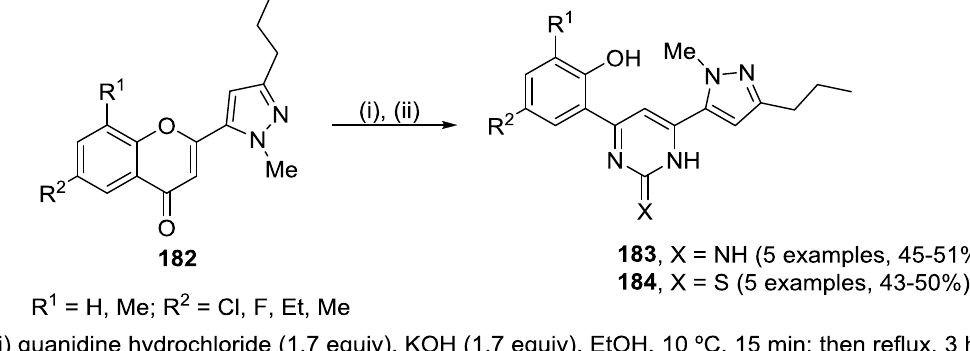
Scheme 63. Transformation of 2-substituted chromone-pyrazole dyads 182 into the corresponding disubstituted 1,2-dihydro-2-iminopyrimidines 183 and 1,2-dihydro-2-pyrimidinethiones 184